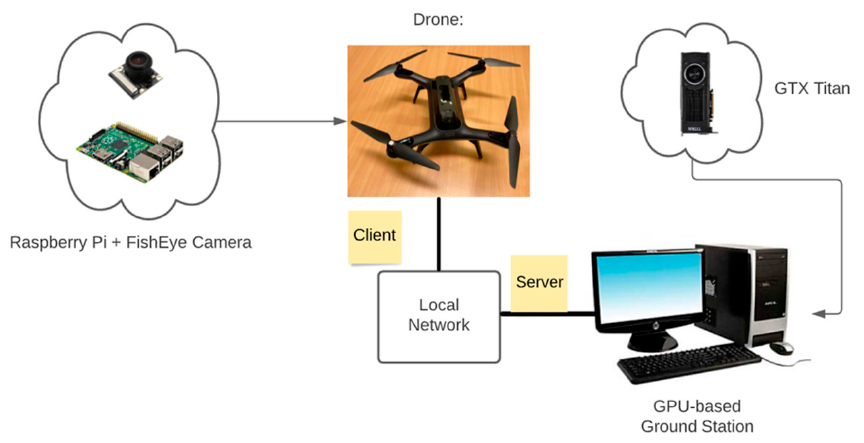
Figure 2. Training and local testing configuration of a Raspberry Pi system UAV with GPU-based ground station for rescue. Table 1. Comparison of NVIDIA GeForce GTX TITAN and Jetson AGX Xavier.